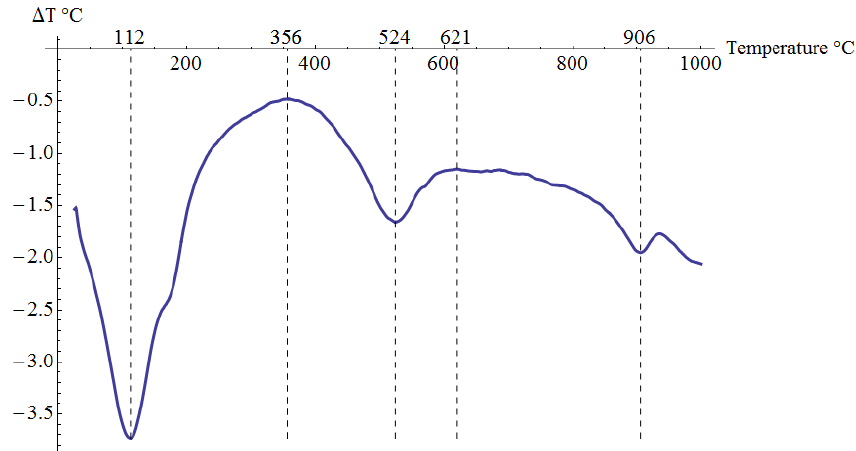
Figure 5. DTA analysis results for the tested material.